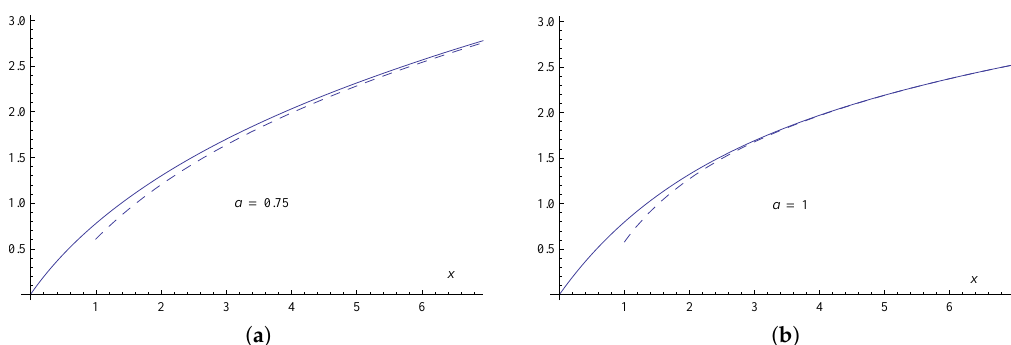
Figure 2. Plots of Ein α ,1 ( x ) (solid curves) and the leading asymptotic approximation (dashed curves) for ( a ) α = 0.75 and ( b ) α = 1.